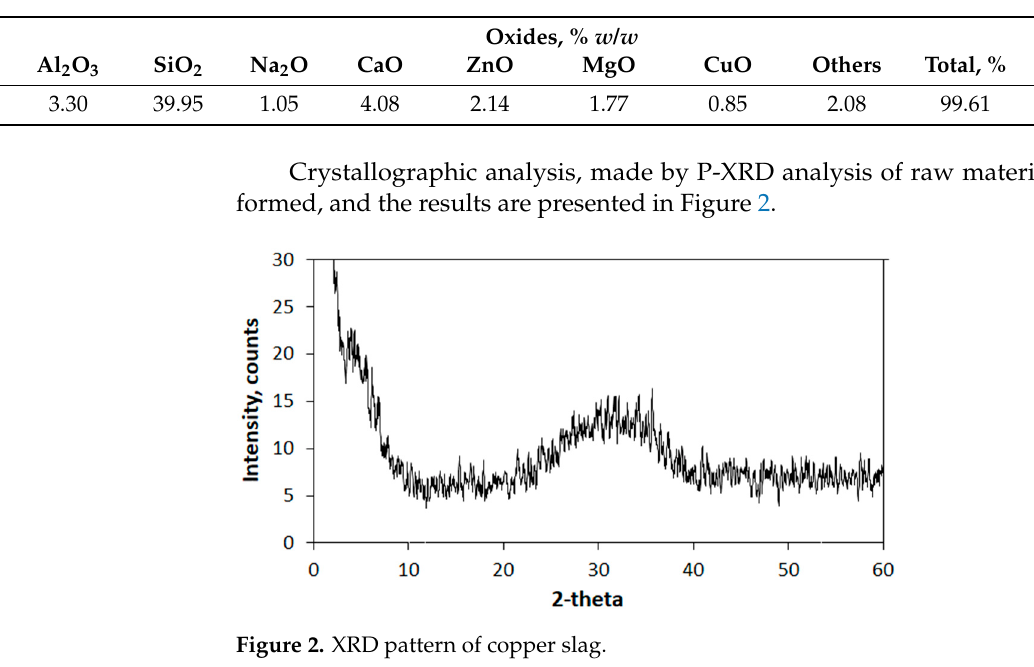
Table 1. Chemical analysis of copper slag.